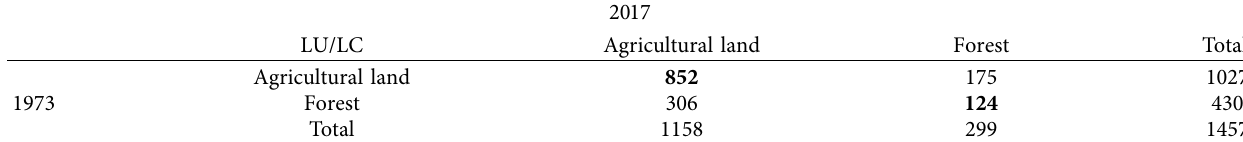
Table 8: Land use/land cover change matrix (ha) between 1973 and 2017.